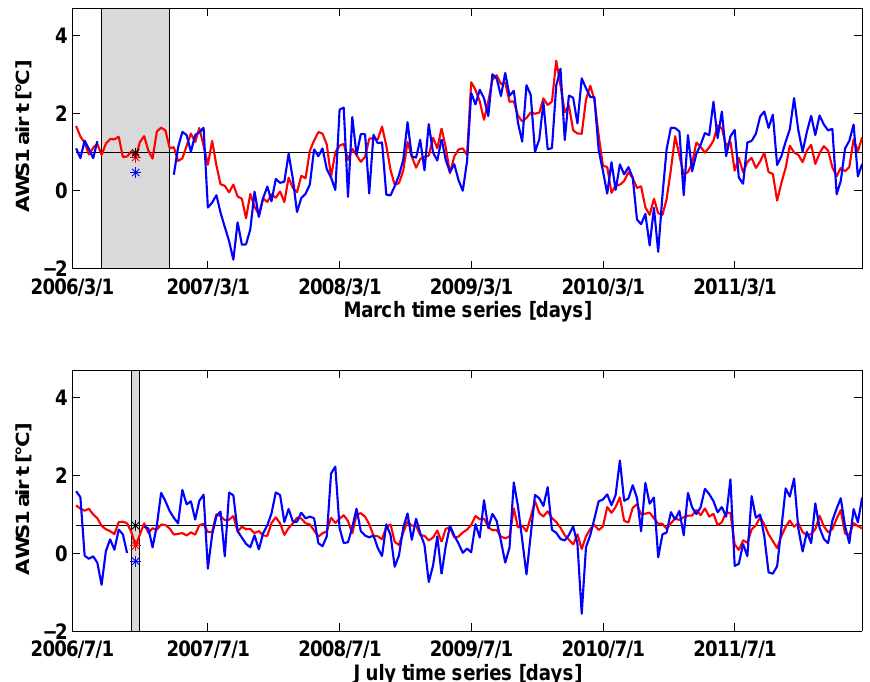
Figure 3. Example of the SD model skill estimation based on cross-validation as described in Sects. 3.3 and 4.1, for AWS1 predictands and the rea-ens-air predictor in March (top) and July (bottom): y T (t) (blue line), ˆ y(t) based on y T (t) (red line), the ˆ y r (black line), y(t) , the observation considered independent from the model process (blue star), the corresponding value of ˆ y V (t) (red star), and of ˆ y r (black star). The gray shaded area highlights the observations left out in the model calibration process (for illustration here, at cross-validation step 15). Note that the gray bar changes its position at each cross-validation step (as described in the